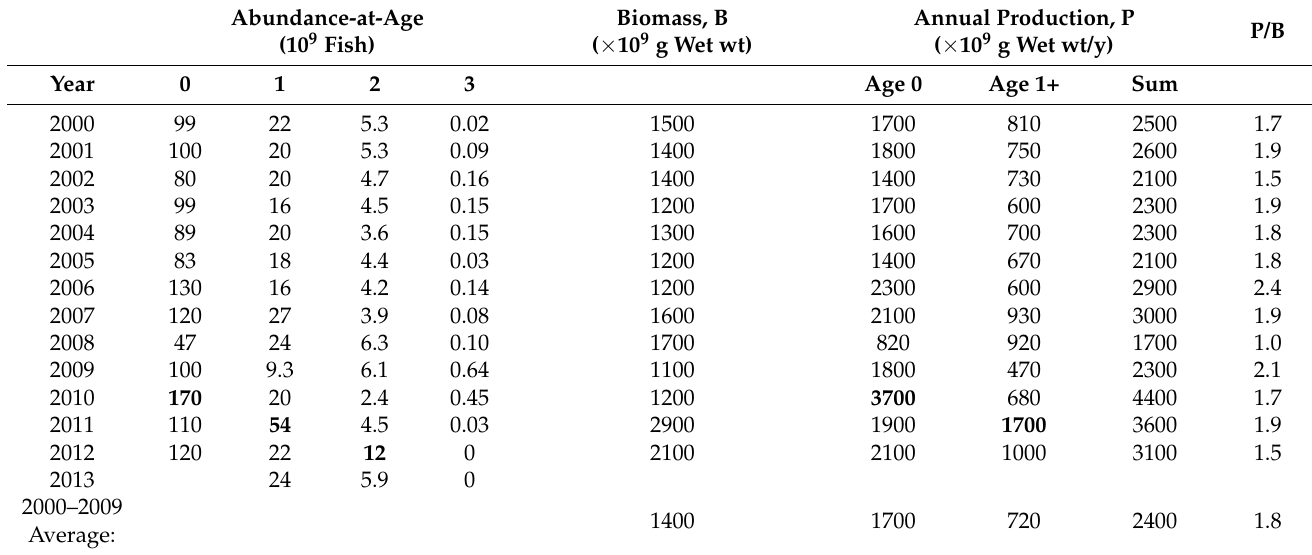
Table 2. Abundance-at-age data used with Equations (1) and (2) (see Methods section) to compute biomass (B), the production (P) of age-0 and age-1+ Gulf menhaden, and the annual ratio of production to biomass (P/B) from 2000 through 2012. Boldface data indicate the 2010 year class. Italics indicate data estimated from Figure 7.11 in [8] for year 2012, and from these estimated 2012 age-0 and age-1 abundances multiplied by e − Ma for year 2013, where M a is the natural mortality rate of 1.62 for age-0 and 1.3 for age-1 fish from Table 3.11 in [8]. Note that 10 9 g = 1000 t.